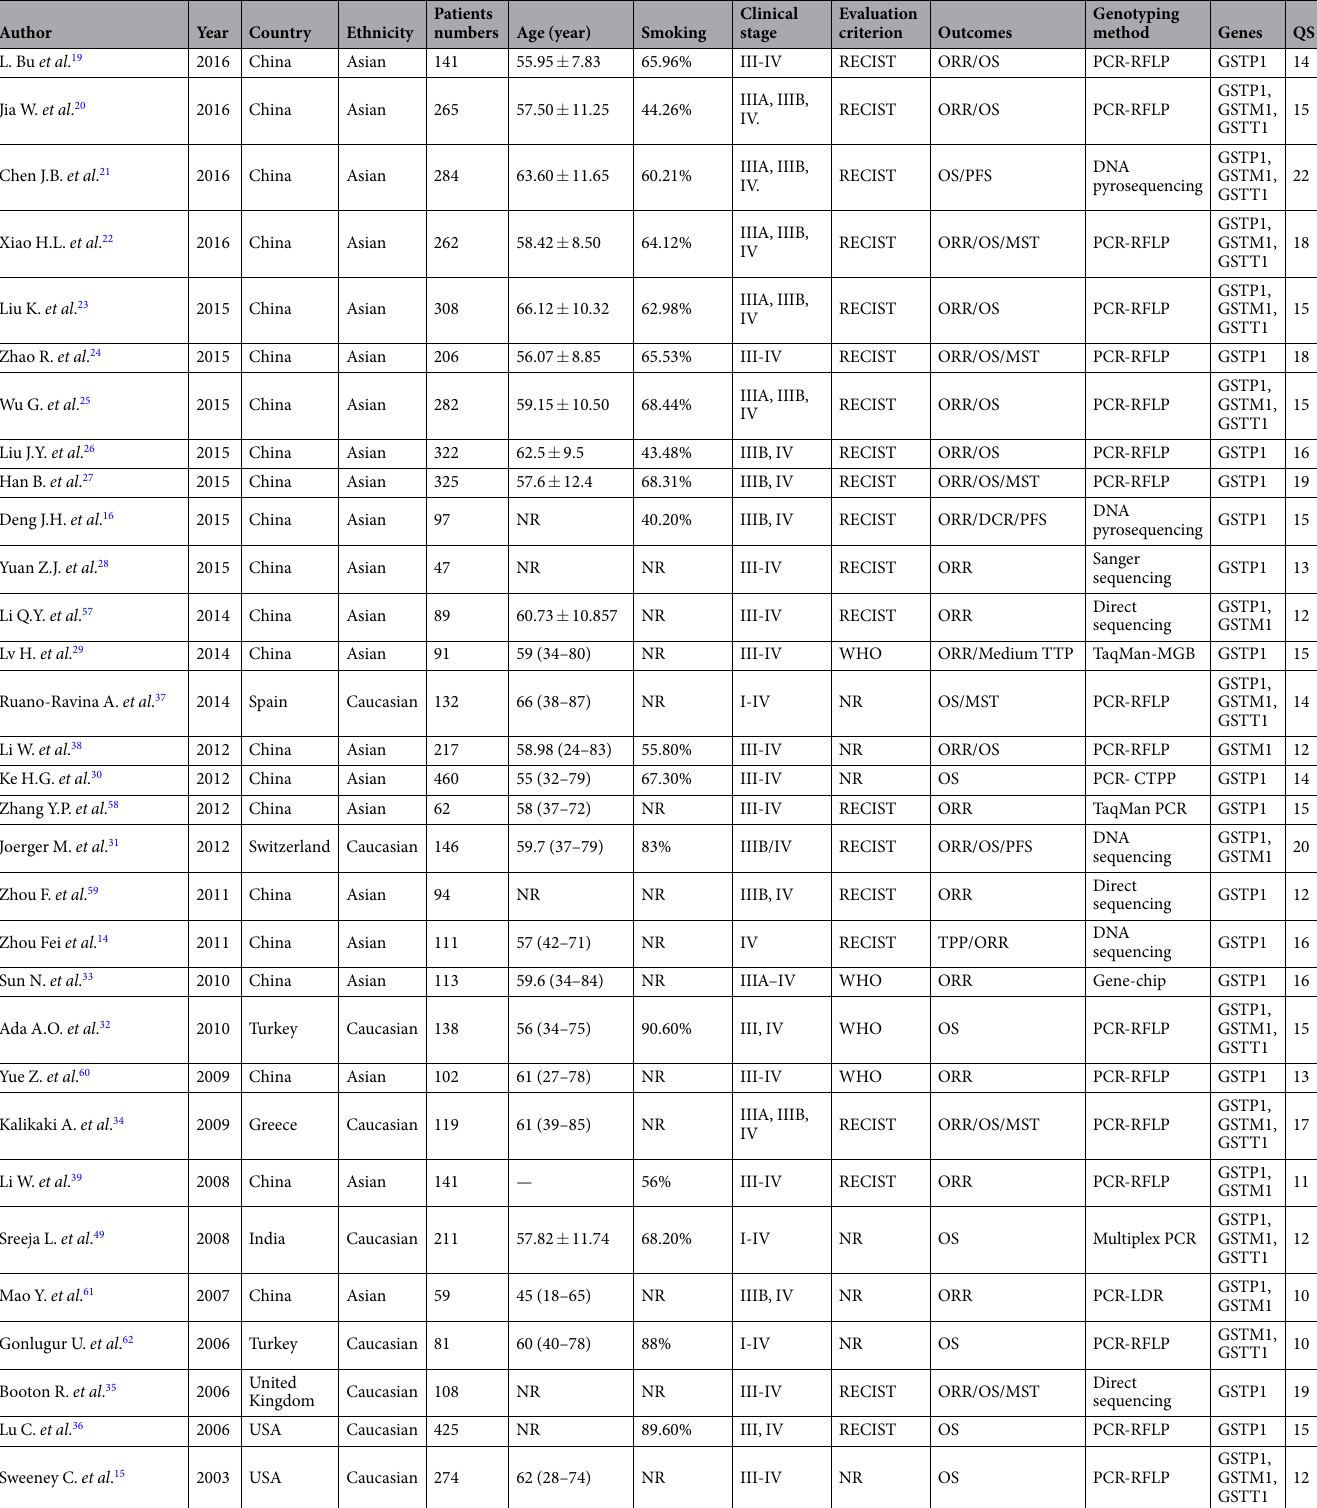
Table 1. Characteristics of studies included in meta-analysis. NR: not reported; QS, quality score; HR: hazard ratio; ORR: objective response rate; OS, overall survival (months); PFS, progression-free survival